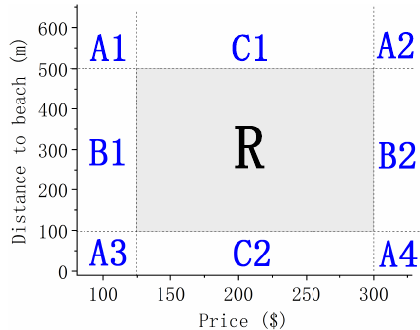
Figure 6. Divide the two-dimensional space.